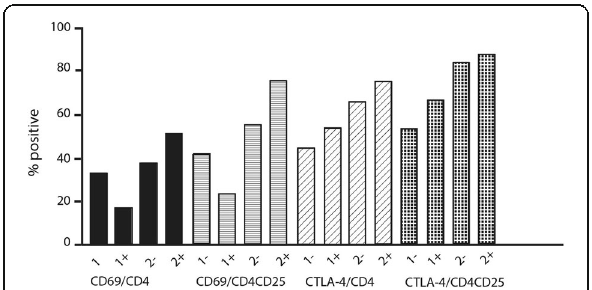
Fig. 3 A summary of the effect of primary and secondary ultrafiltrates on expression of CD69 and CTLA-4 by T cells stimulated with anti-CD3/ CD28. The - indicates media (1=primary) or secondary ultrafiltrate (2) generated from media treated cells while + indicates synovial fluid ultrafiltrate (1) or secondary ultrafiltrate generated from synovial fluid ultrafiltrate treated cells